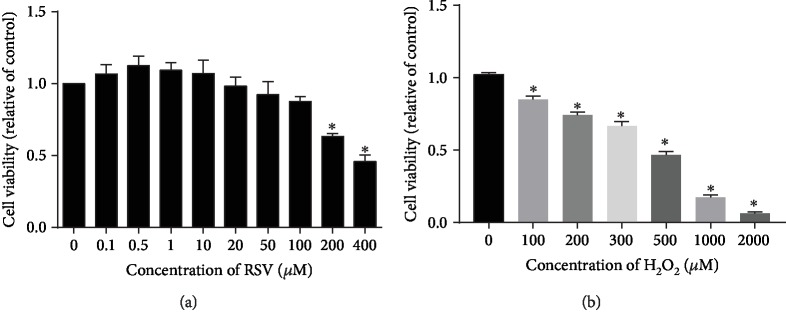
Effects of RSV and H2O2 on the viability of IPEC-J2 cells. (a) IPEC-J2 cells were incubated with increasing concentrations of RSV for 6 h (a) and H2O2 for 4 h (b), and then cell viability was measured by CCK-8 assays. Results are presented as the percentage of cell viability compared with the control (0 μM). Values are the mean ± SE; n = 8. Asterisks indicate a significant difference compared to the control group (P < 0.05).